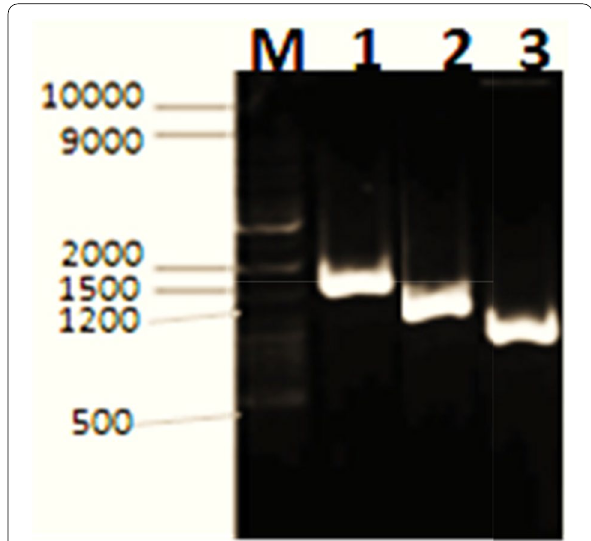
Fig. 2 Agarose gel electrophoresis of the amplified PCR fragment‑ insert using M13 primer for different positive recombinant clones 1, 2, and 3. M: 10 kb DNA